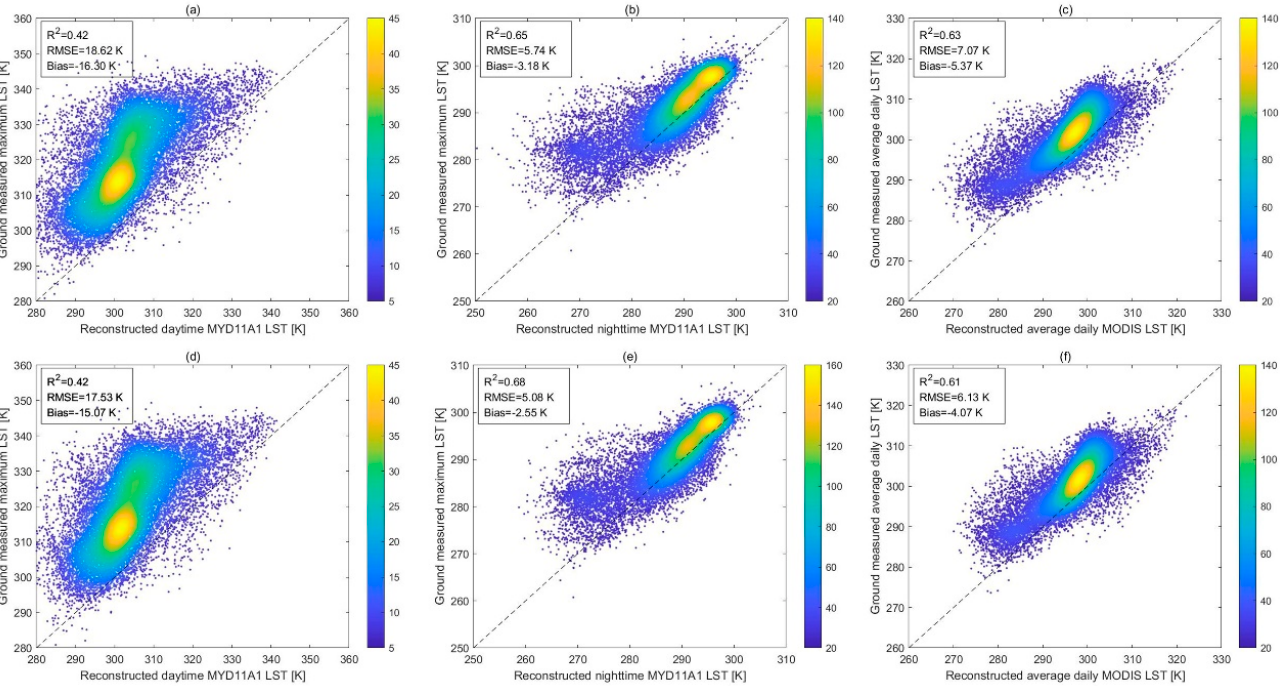
Figure 9. Validation results for reconstructed ( a ) MYDLSTD_Rec; ( b ) MYDLSTN_Rec_SG; ( c ) MODLSTAvg_Rec; ( d ) MYDLSTD_Rec_SG; ( e ) MYDLSTN_Rec_SG, and ( f ) MODLSTAvg_Rec_SG using CMA LST data from June to August 2018. Color bar represents the counts of the points falling in each square.